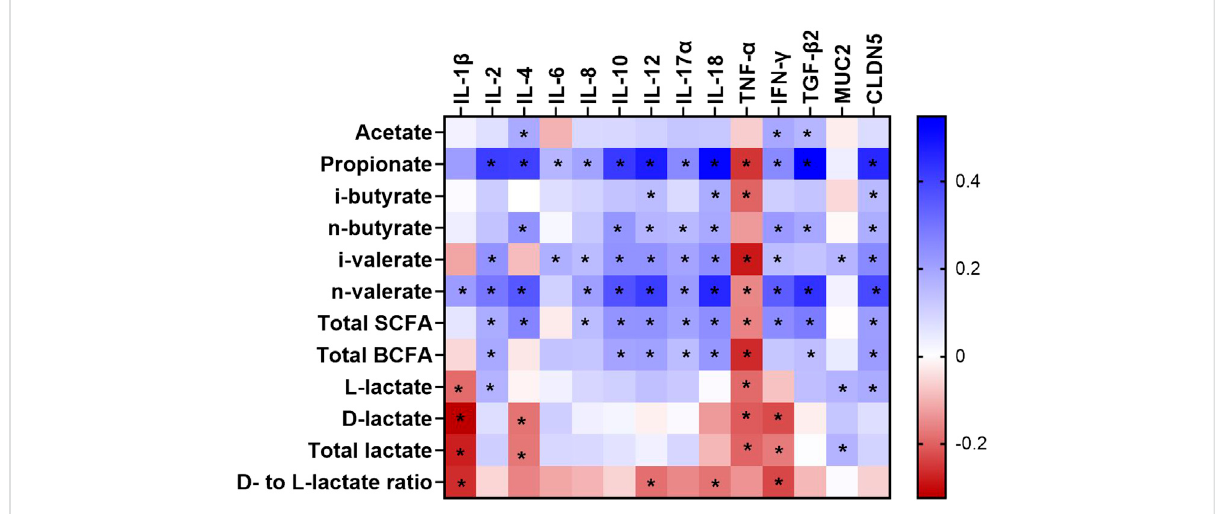
FIGURE 1 A heatmap showing the Spearman ’ s correlation coef fi cient between metabolites and mRNA abundance in the caecum of broilers between day 7and 35ofage. Thecolorsrepresent thecorrelation, withbluebeingmore positive andredbeingmore negative.Signi fi cance isgivenas*( p < 0.05). SCFA, short chain fatty acid; BCFA, branched chain fatty acid; IL, interleukin; TNF- α , tumor necrosis factor alpha; IFN- γ , interferon gamma; TGF- β 2, transforming growth factor beta 2; CLDN5, Claudin 5; MUC2, Mucin